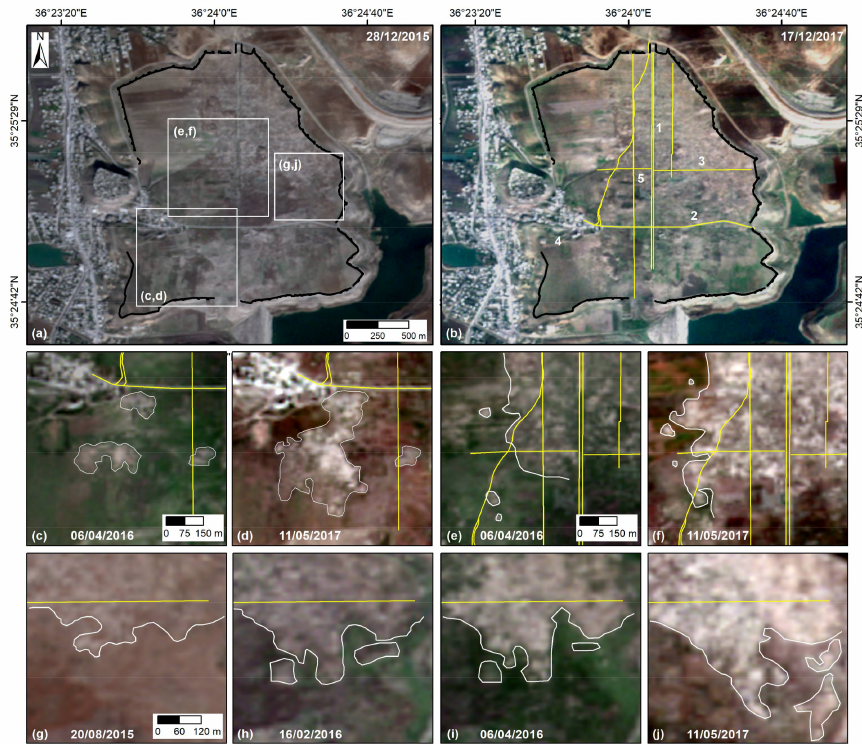
Figure 4. View of the archaeological site of Apamea (Syria) from Sentinel-2 images acquired on ( a ) 28 December 2015 and two years later on ( b ) 17 December 2017 with the locations as follows: (1) Cardo Maximus; (2) main Decumanus; (3) second main Decumanus; (4) Roman theatre; and (5) Agora. Zoomed images of the new looted areas detected with the Sentinel-2 time series analysis, southeast of the Roman theatre on ( c ) 6 April 2016 and ( d ) 11 May 2017; west of the Cardo Maximus and the Agora on ( e ) 6 April 2016 and ( f ) 11 May 2017; and east, along the second main Decumanus on ( g ) 20 August 2015, ( h ) 16 February 2016, ( i ) 6 April 2016, and ( j ) 11 May 2017. Copernicus Sentinel-2 images © 2015–2017 European Space